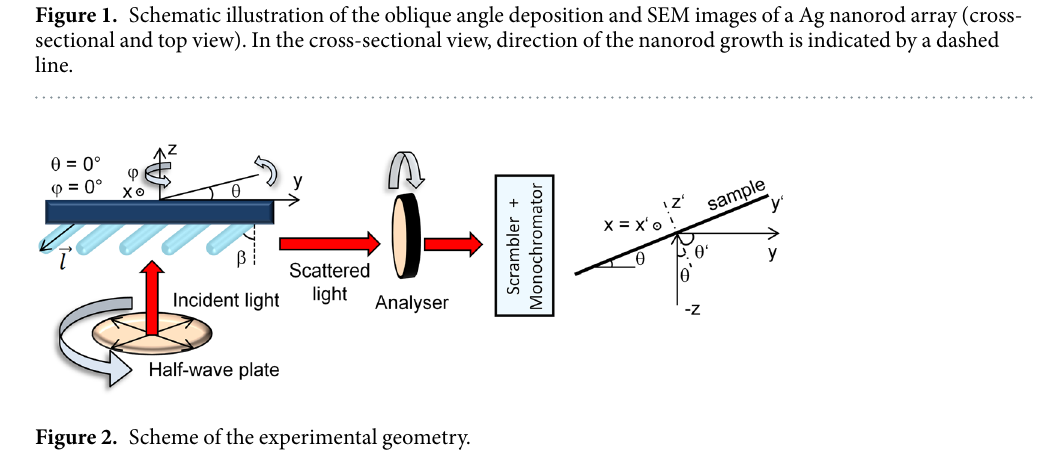
Figure 2. Scheme of the experimental